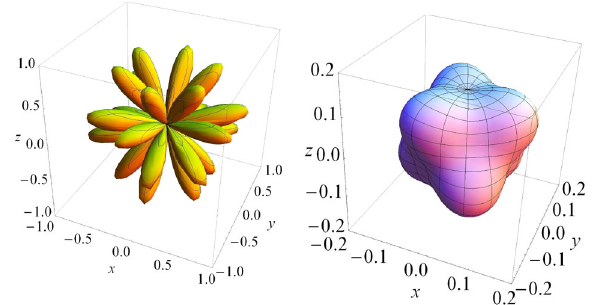
FIG. 4. The primitive polynomials have beautiful geometric shapes when plotted in N − 1 -dim spherical coordinates. Shown above are the constant W plots of the antisymmetric polynomial A diagram) and the degree m ¼ 4 symmetric expression in the orthonormalized space spanned by the elementary symmetric polynomials 1 ; S 2 ; S 3 ; S 4 , and S 2 2 (right diagram). On the left, there are 24 lobes that each maximally avoid the vertices of the tetrahedron (3-simplex). On the right, the six lobes lie around the centers of the six edges of the tetrahedron, where two of the ¯ n i ’ s are